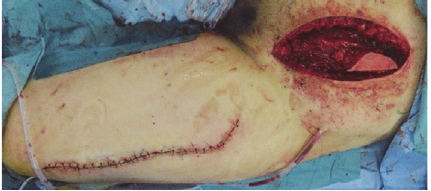
Figure 2: The flap was tunneled under the rectus femoris muscle and transferred to the abdominal wall defect.